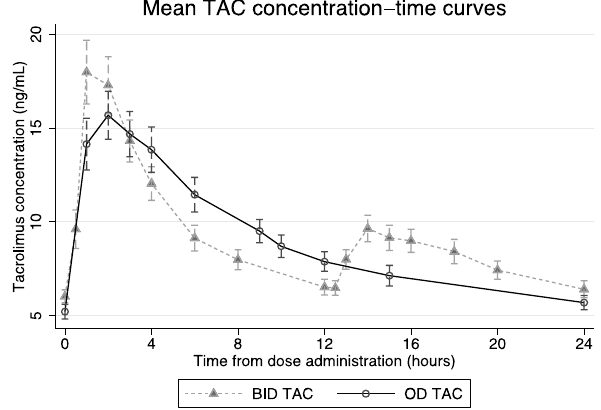
Figure 1. The mean tacrolimus concentration–time curves of both OD TAC and BID TAC.